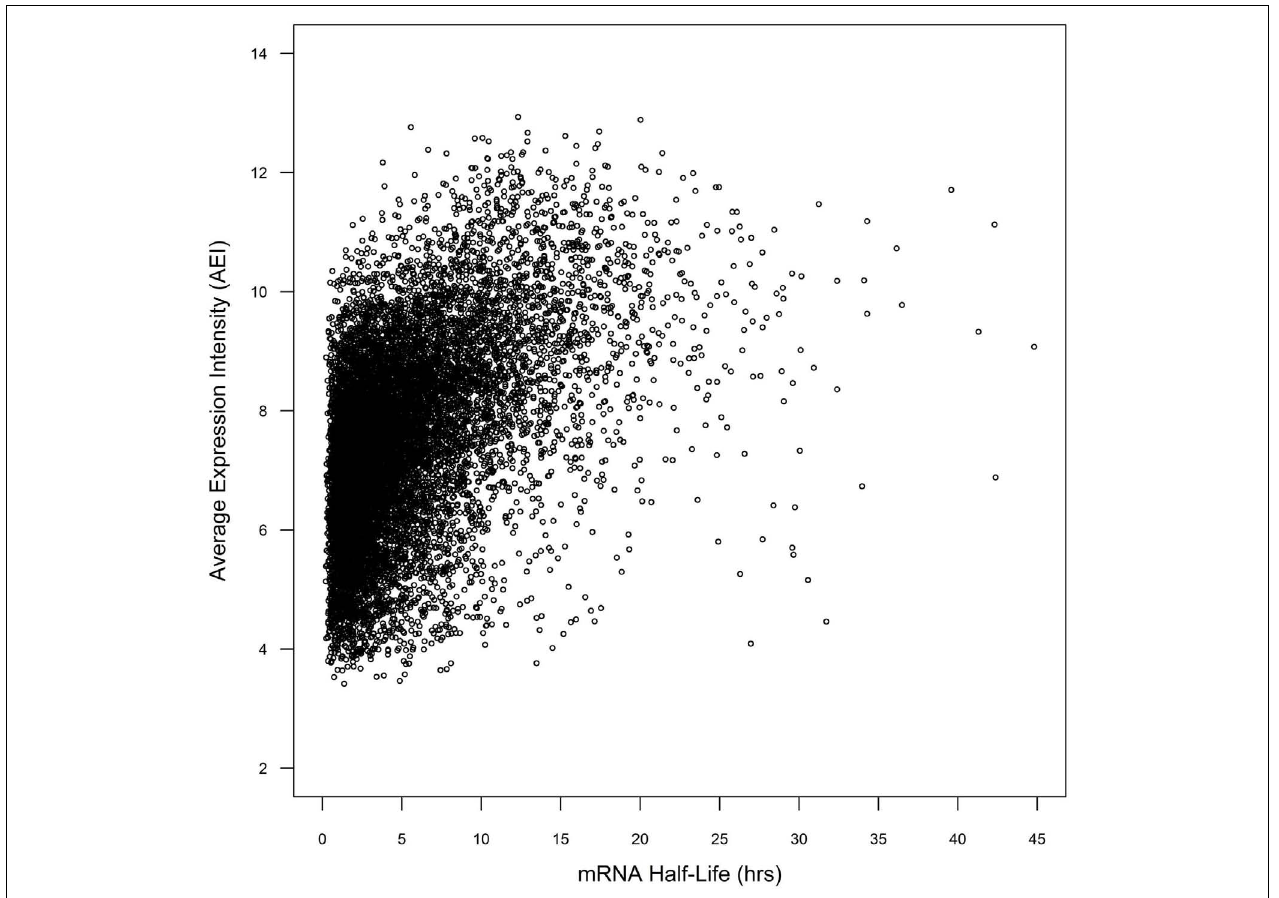
FIGURE 1 | Comparison of mRNA half-life vs. average expression intensity across genome